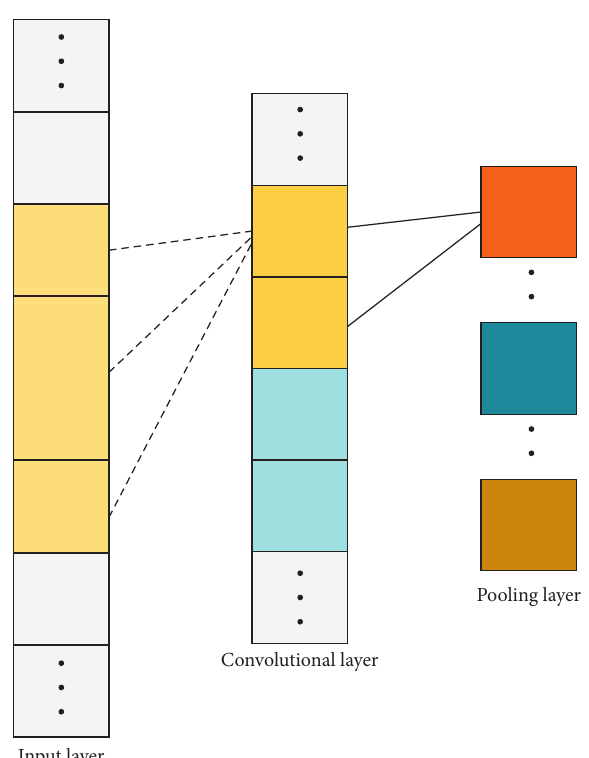
Figure 4: One-dimensional convolutional neural network